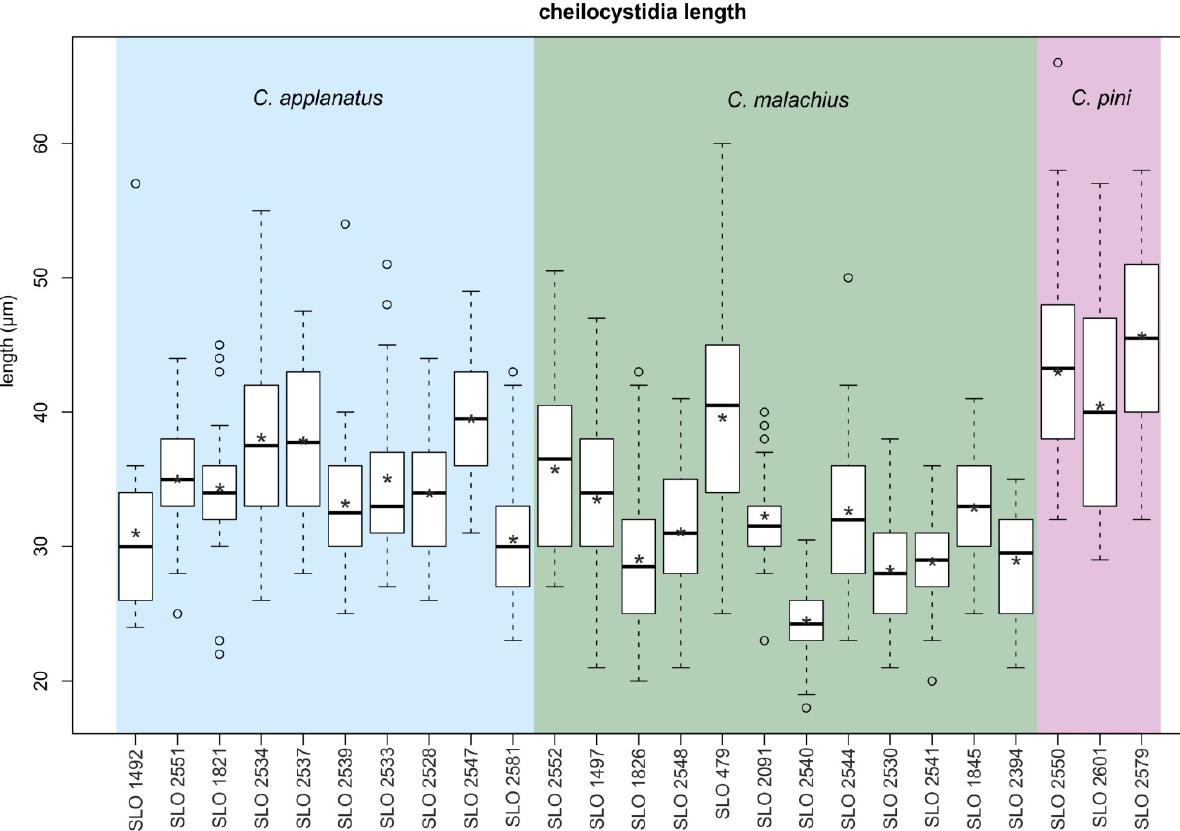
Table 1. Basidiospore and cheilocystidia characteristics measured on Crepidotus applanatus ( n = 300), C. malachius ( n = 360) and C. pini ( n = 90). The size of basidiospores and cheilocystidia, the length/width ratio of basidiospores (Q), and the frequency of occurrence of cheilocystidia types (mostly = 50.1–99%, often = 25.1–50%, sometimes = 5.1–25%, rarely = 0.1–5%) was calculated based on the sequenced specimens (Supplementary Tables S1–S4); n = total number of measurements (30 measurements per specimen); the measurements are presented as averages ± standard deviation, values in parenthesis = minimum and maximum.